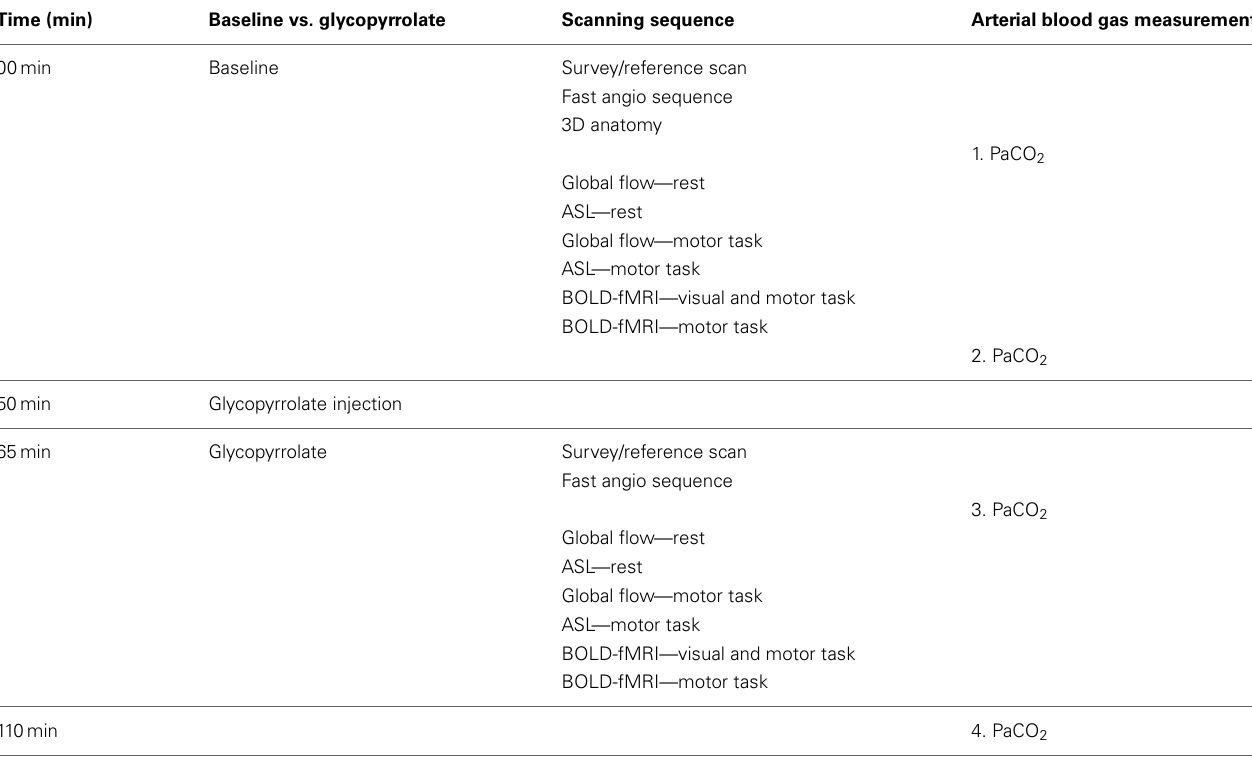
Table 1 | The study protocol.